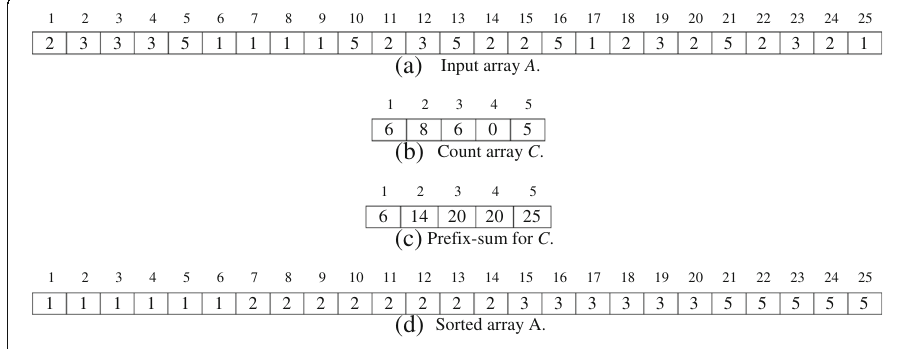
Fig. 1 Tracing of the CS algorithm in case of O ( m ) < O ( n ). a Input array A . b Count array C . c Prefix-sum for C . d Sorted array